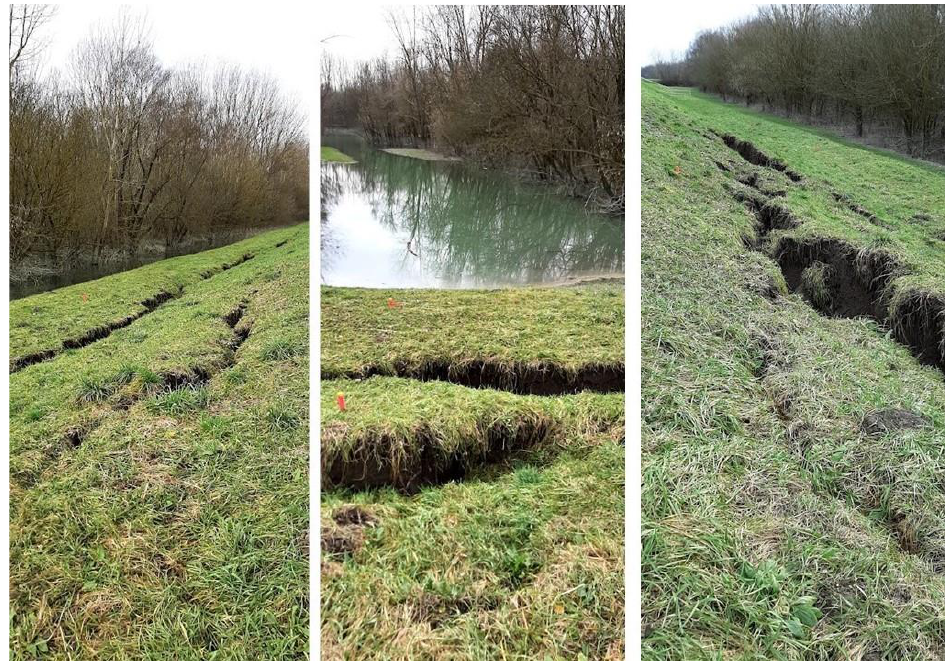
Figure 6. Typical embankment damage at Galdovo are longitudinal cracks with a depth of 2 m or more.